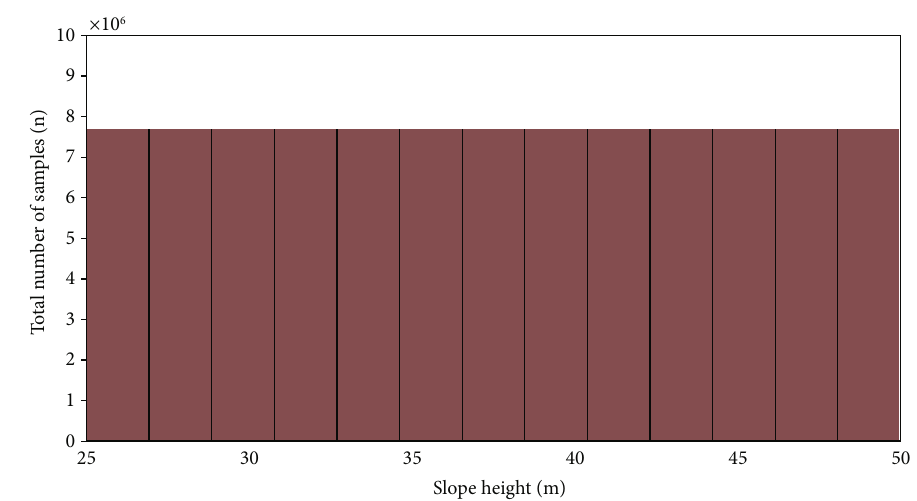
Figure 11: Statistical histogram of slope height